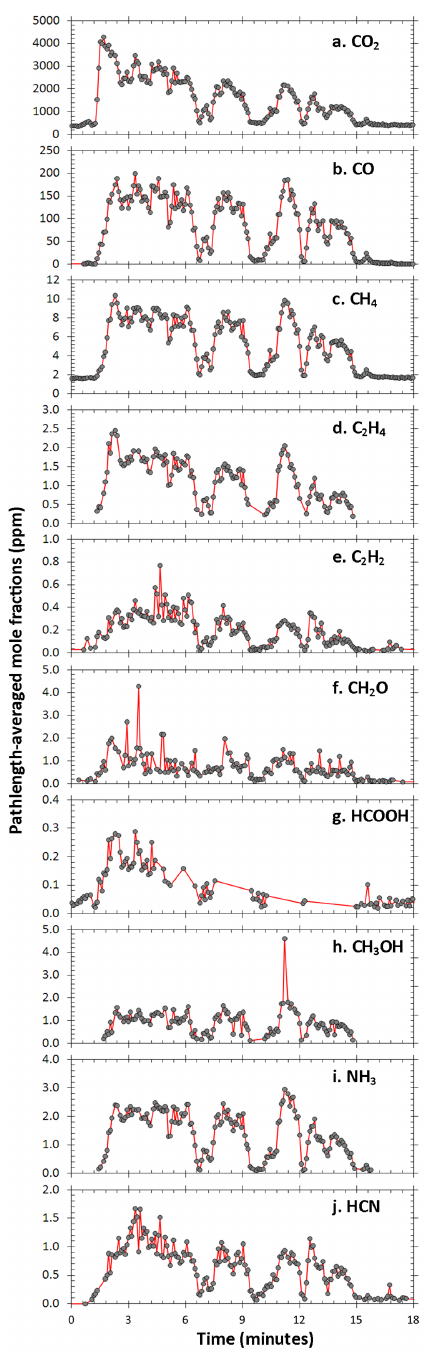
Figure 6. Time series of path-averaged trace gas mole fractions (in ppm) for plot LD-TGOW-A (30 September 2009) during the late- dry season Arnhem Land campaign. Trace gas path-averaged mole fractions were retrieved from the OP-FTIR spectra using MALT. An example smoke spectrum with the best-fit modelled spectrum for each of the spectral windows used to retrieve the mole fraction of each of the trace gases presented in this figure can be found in Fig. 2. Gaps in the time series of specific trace gases are due to periods of low signal-to-noise within the spectral window used for the retrieval of that particular